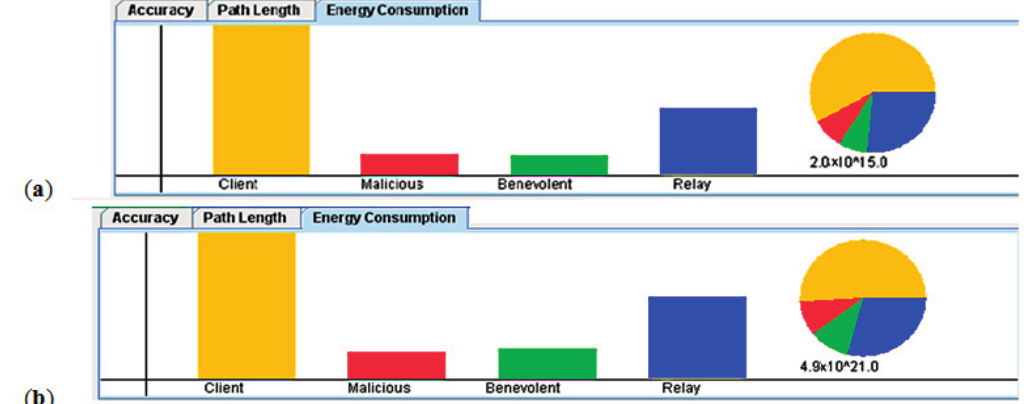
Figure 11. The effect of increaseing the radio range: ( a ) Low radio range ; and ( b ) High radio